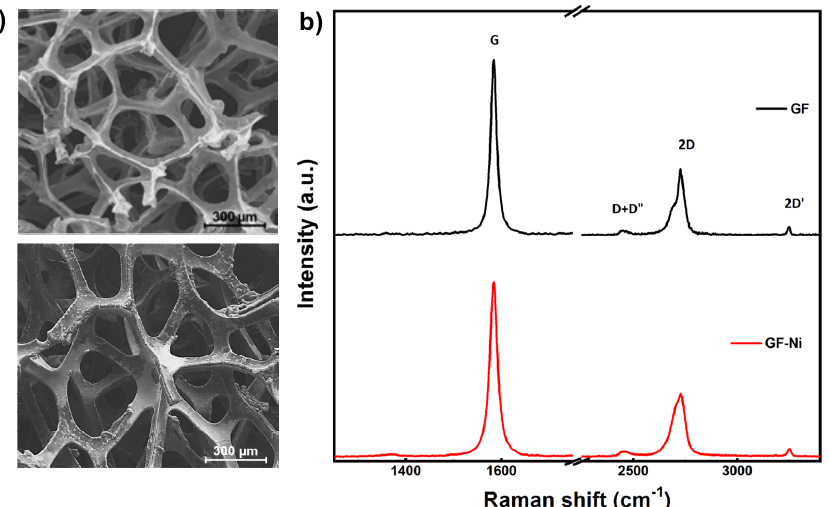
Figure 8. 3D graphene structural and surface morphology characterizations: ( a ) SEM images for (bottom) as grown 3D graphene on nickel (GF - Ni) and (top) free-standing 3D - graphene (GF); ( b ) corresponding typical Raman spectra of (bottom) GF - Ni; (top) GF Reprinted from ref. [57] with permission from Elsevier B.V.